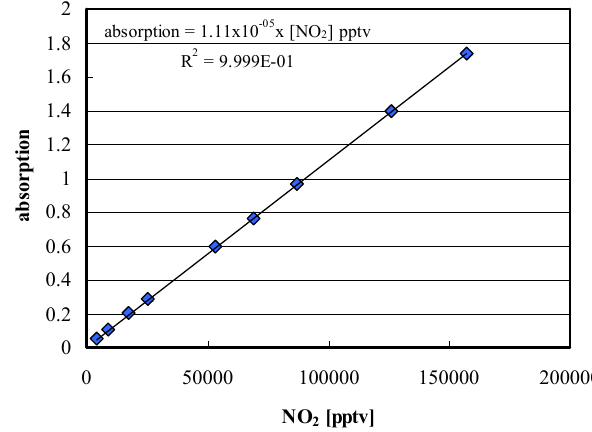
Fig. 6. Time resolution (3min) and precision (2 σ , 0.5%) of Fig. 6 Time resolution (3 min) and precision (2 σ , 0.5 %) of the NO 2 -LOPAP instrument Fig. 7. NO 2 concentration dependency of the LOPAP signal us- the NO 2 -LOPAP instrument using recommended sampling solu- Fig. 7 NO 2 concentration dependency of the LOPAP signal using recommended ing recommended sampling solution (see Table 1) and instrument using recommended sampling solution (see Tab. 1) and instrument parameters tion (see Table 1) and instrument parameters (see Table 2, liquid sampling solution (see Tab. 1) and instrument parameters (see Tab. 2, liquid flow parameters (see Table 2, liquid flow=0.35mlmin − 1 flow=0.35mlmin − 1 ). (see Tab. 2, liquid flow = 0.35 ml/min). = 0.35 ml/min).